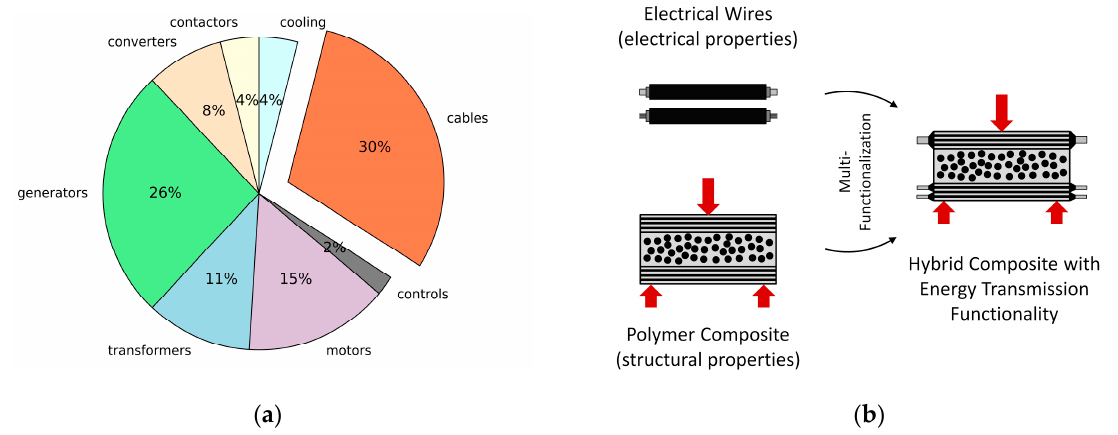
Figure 1. ( a ) Electrical system weight of an electric 300-seater aircraft, according to Gohardani et al. [8]; ( b ) concept of multifunctional electrically conductive and load-bearing (red arrows) composites for transferring energy from storage to electrical consumers.